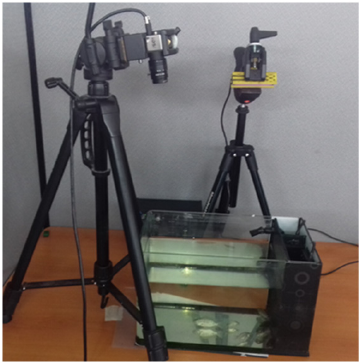
Figure 3. Second system configuration.